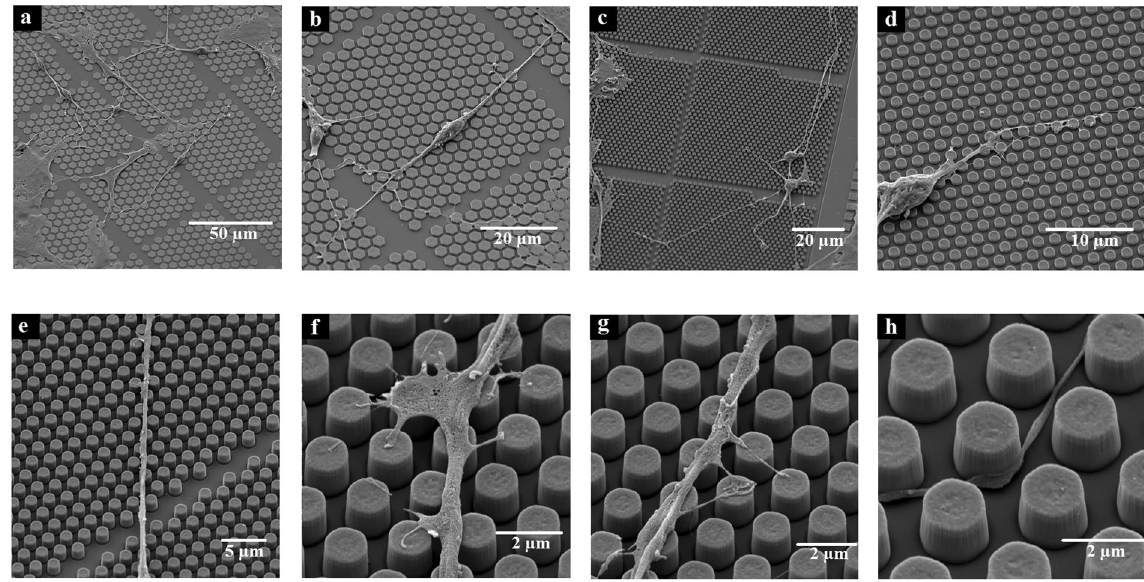
Figure 7. SEM images of spiral ganglion neurons cultured on CMOS chips. ( a ) SGNs cultured on CMOS chip. ( b ) Bipolar neuron cultured on CMOS chip. Neurites grow in straight lines. ( c ) Two neurons grow on top of the CMOS chips without the favorable flat surface of the chip. ( d ) SGN cell soma with the neurite following micro- pillars on the CMOS chip. ( e ) The neurite is guided by micro-patterned surface of the chip, follows a single angle determined by the spatial distribution of the pillars and can cross a small divide of 2 µ m without pillars between microcells (see Fig. 1) and attaches to the pillars on the other side of the divide; ( f ) Growth cone formation on micro-pillars of the CMOS chips serves for axon repositioning; ( g ) One neurite with protruding branches seeking interaction with pillars; ( h ) one neurite passing between pillars showing how it touches pillars, probably in order to maintain the contact guidance.